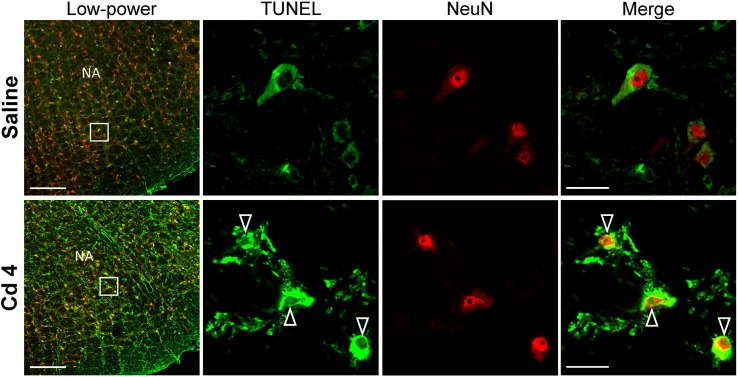
Illustrative examples of in situ detection of apoptosis in RVLM neurons using TUNEL assay (green fluorescence) and staining for the neuronal marker, NeuN (red fluorescence) in rats 10 min after saline or cadmium (Cd; 4 mg/kg, iv). White arrows denote TUNEL-positive staining in the nucleus of cells that additionally exhibit NeuN-immunoreactivity. Box in low-power view of the medulla oblongata indicated the location of TUNEL-positive neurons. Scale bar, 20 μm in low-power view or 200 μm in high-power view. NA, nucleus ambiguus.